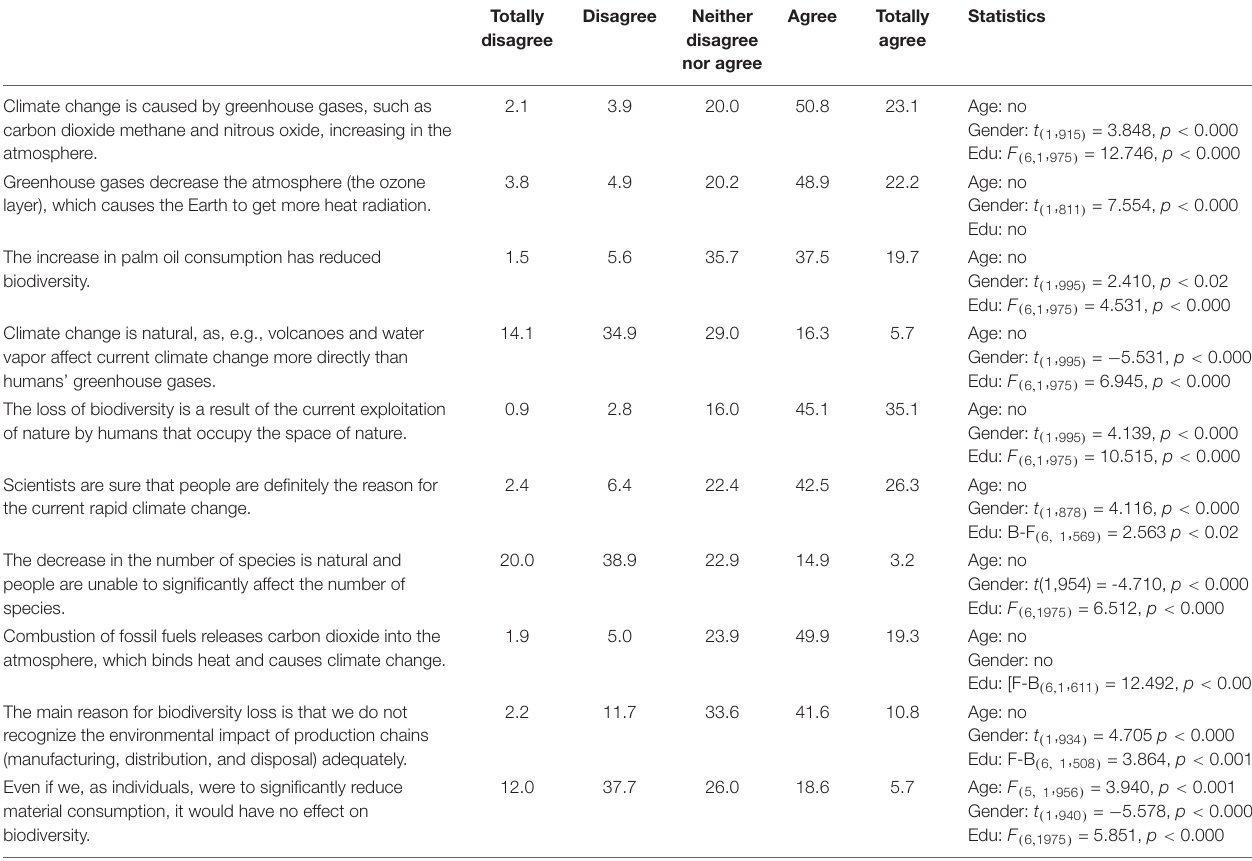
TABLE 2 | Finnish people’s environmental awareness ( n = 2006).